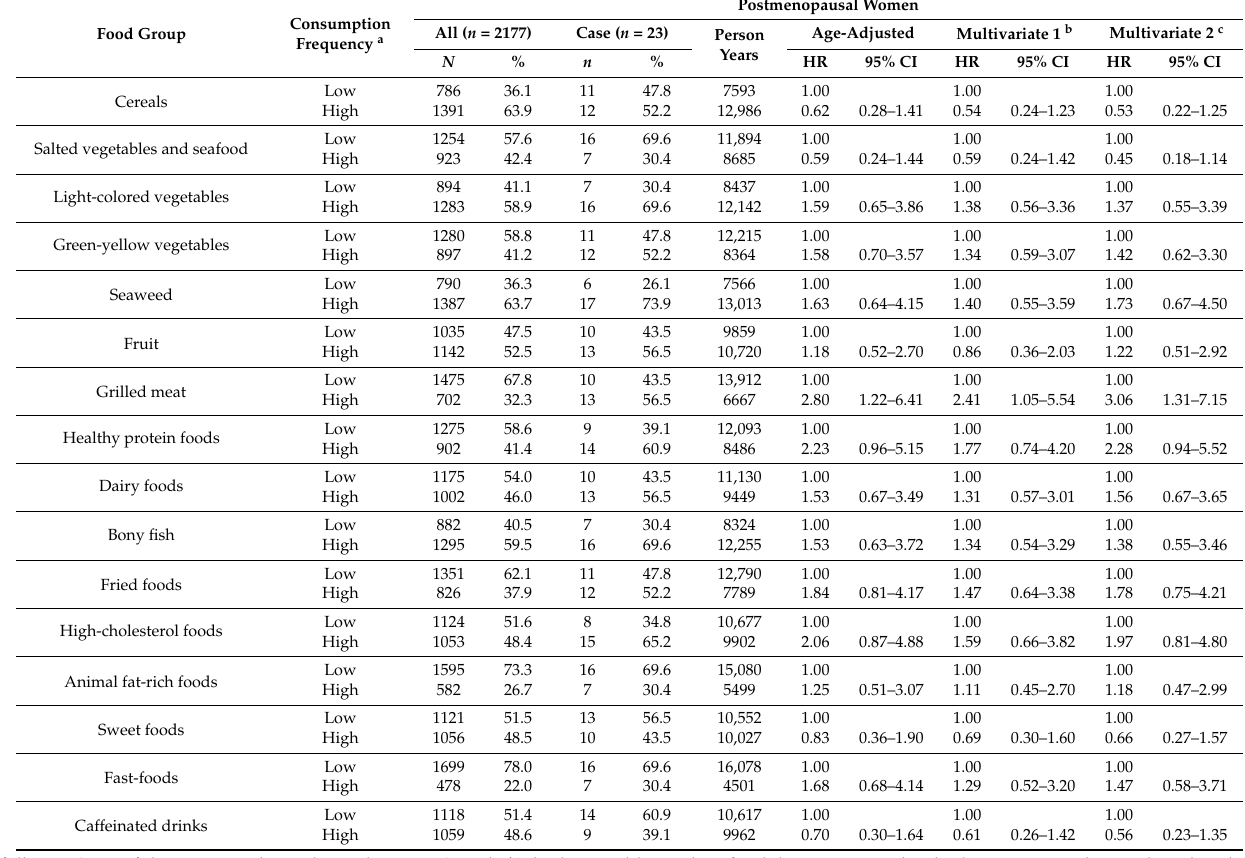
Table 4. Sixteen food groups and their associations with the risk of breast cancer in postmenopausal